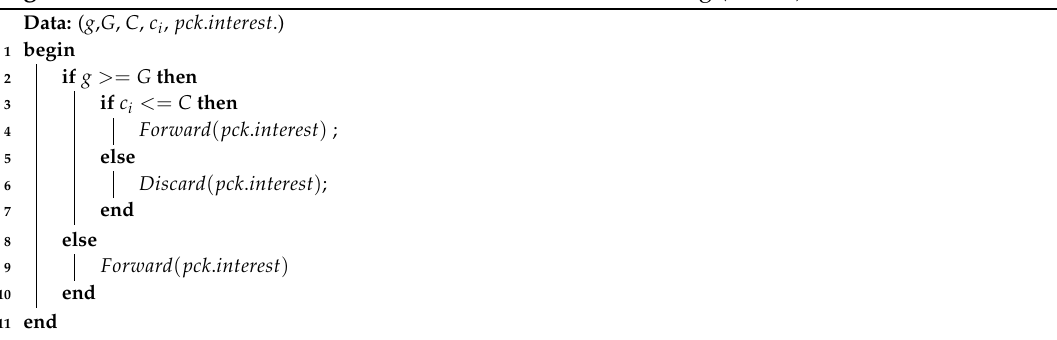
Algorithm 2: Retransmission-Counter-based Interest Forwarding (ReCIF)-hard mechanism. Data: ( g , G , C , c i , pck . interest .)